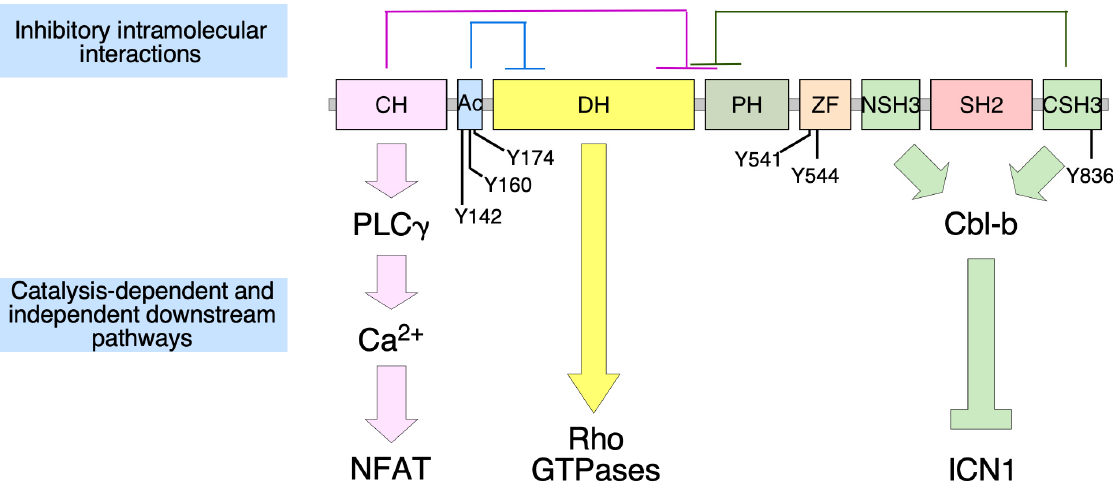
Figure 1. Depiction of the structure, the main regulatory phosphosites (using the amino acid sequence corresponding to mouse Vav1), the intramolecular autoinhibitory interactions that take place in the nonphosphorylated state of Vav proteins (top), and some of the main downstream pathways described for specific mammalian Vav family members (bottom). NFAT, nuclear factor of activated T cells (a transcriptional factor involved in the proliferation and cytokine production of T lymphocytes); ICN1, intracellular domain of Notch1. The rest of abbreviations are described in the main text.